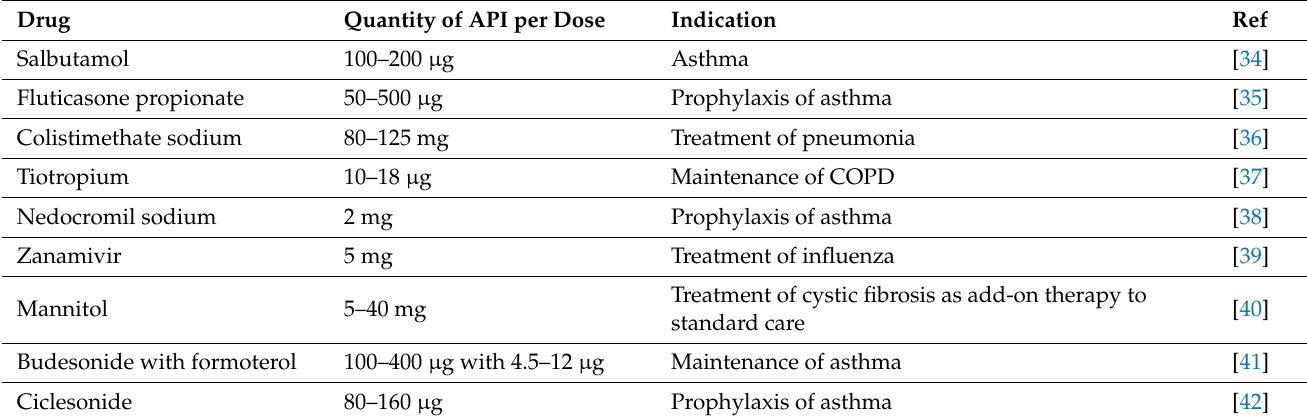
Table 2. Examples of currently available inhaled products in the